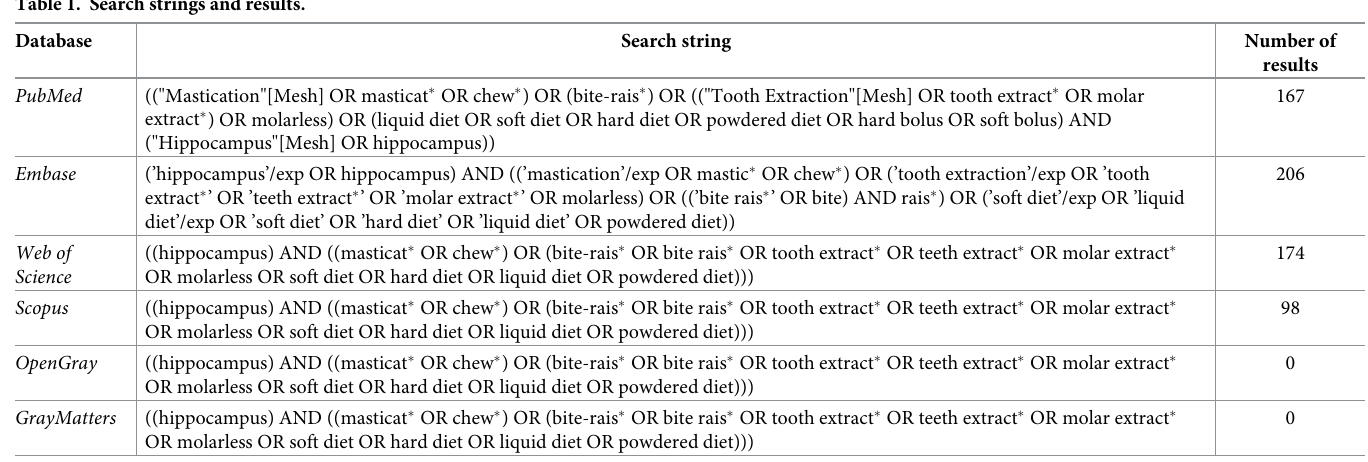
Table 1. Search strings and